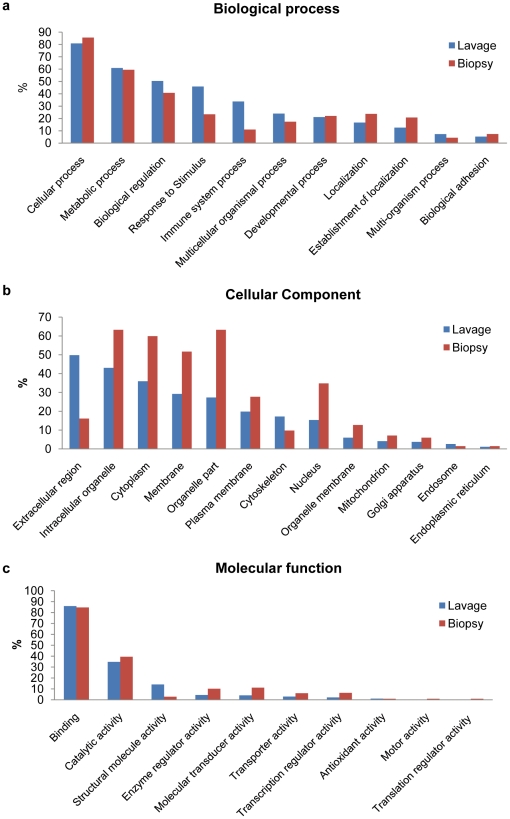
Comparison of lavage and biopsy samples by protein annotations.a. Biological process. b. Cellular component. c. Molecular function.